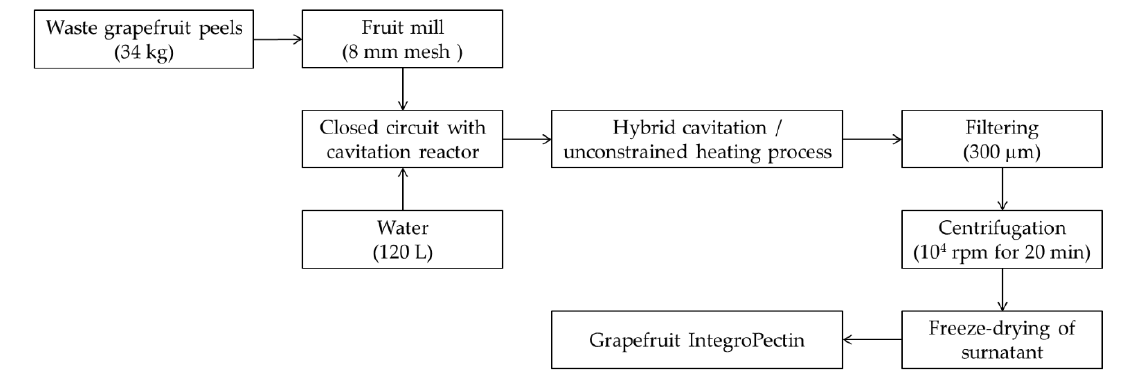
Figure 1. Schematic diagram for the production of grapefruit IntegroPectin.